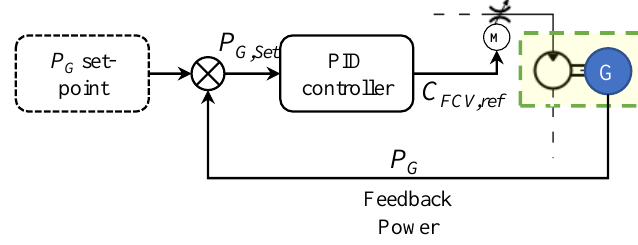
Figure 4. A closed-loop PID controller for flow control